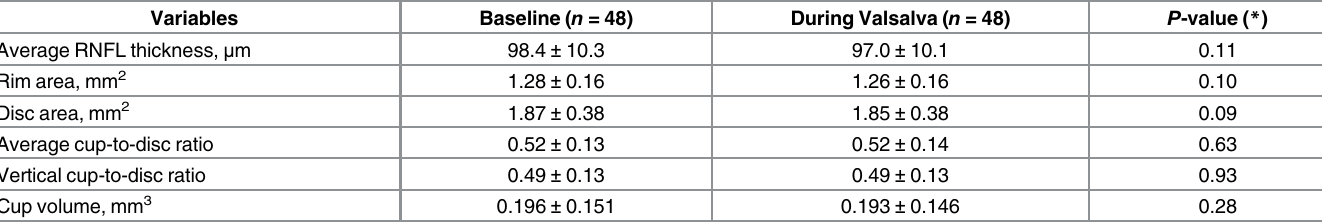
Table 2. Optic nerve head parameters change during standardized Valsalva maneuver.